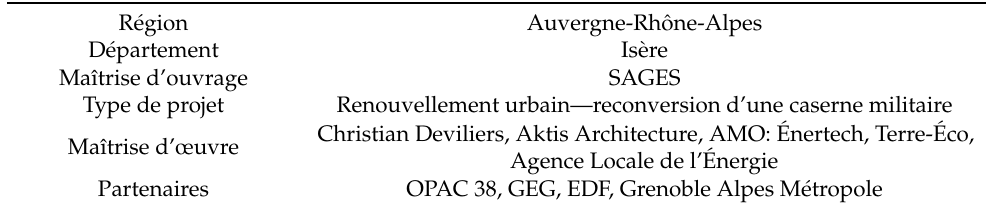
Table 7. Zac de Bonne. Source: Authors’ elaboration (2022) based on data from the site